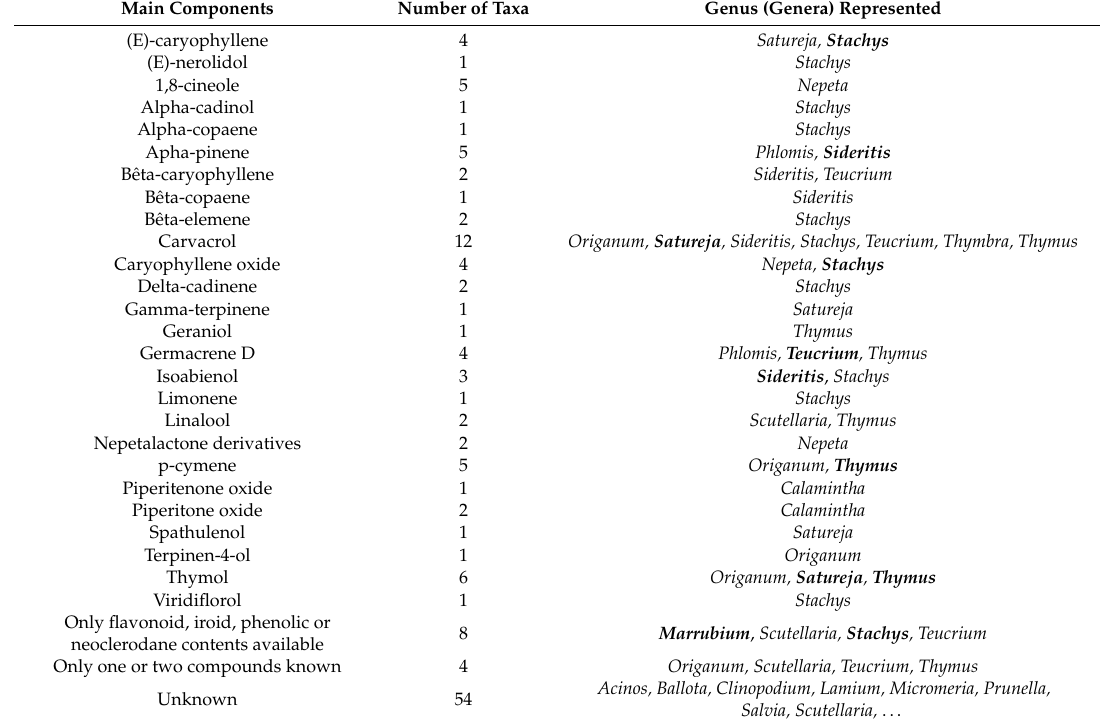
Table 1. Main components of Greek endemic Lamiaceae, assigned to number of taxa and genus / genera represented. Genera in bold characters represent the genus with most taxa per main